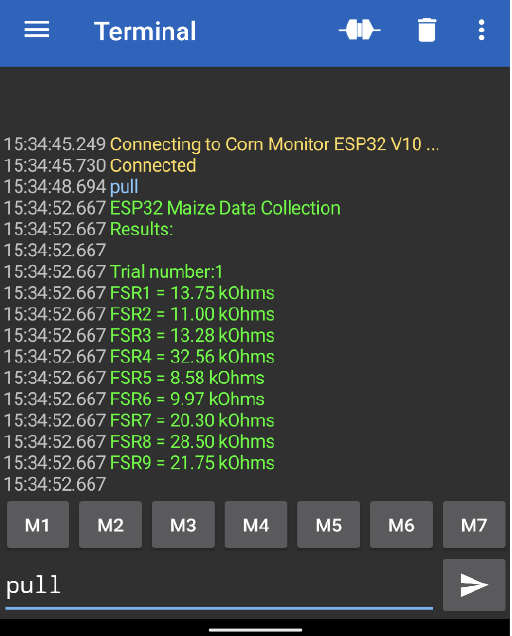
Figure 7. A screenshot of the pulled FSR values from ESP32 through the Bluetooth connection.